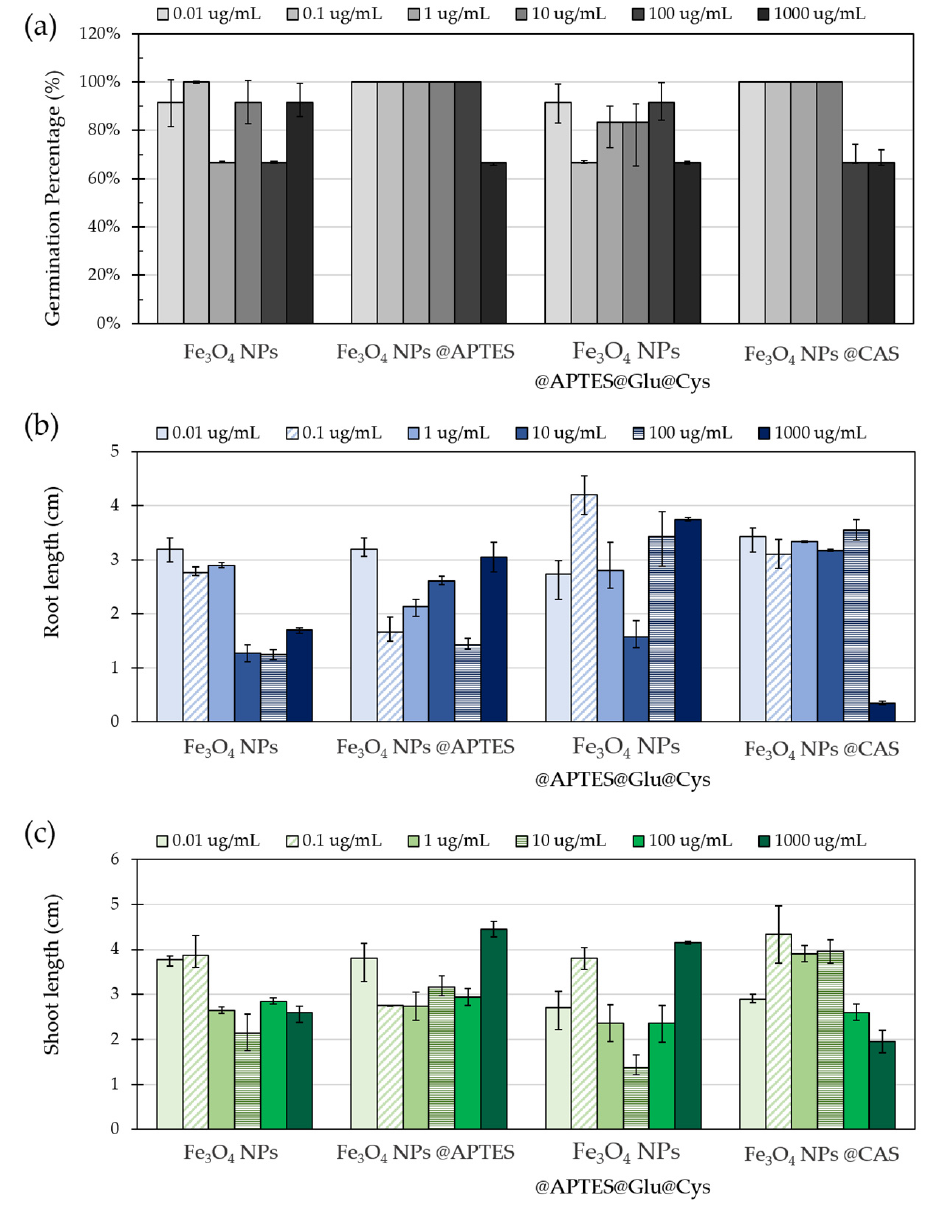
Figure 8. ( a ) Germination percentage, ( b ) root and ( c ) shoot length of ryegrass seed after 6 days of exposure to bare Fe 3 O 4 NPs and Fe 3 O 4 NPs functionalized with APTES, APTES@Glu@Cys and CAS.